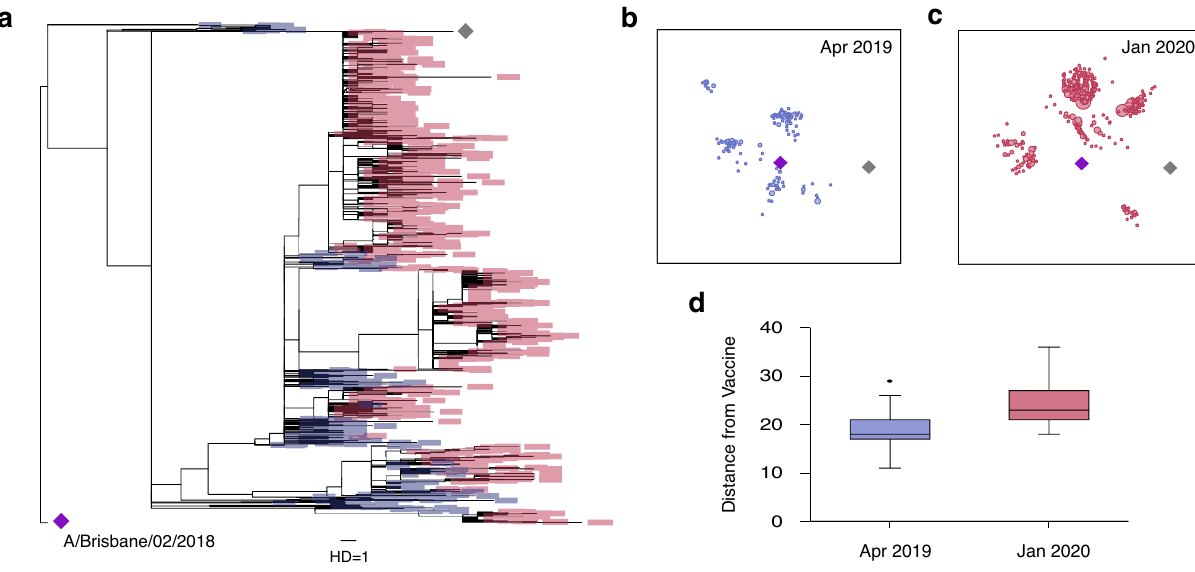
Figure 4. Influenza A (H1N1) evolution and vaccination. (a) Maximum likelihood tree of 255 H1N1 Hemagglutinin (HA) sequences sampled in April 2019 (blue boxes), 1140 H1N1 HA sequences sampled in January 2020 (red boxes), 2019–2020 H1N1 Northern hemisphere vaccine strain (A/Brisbane/02/2018, purple diamond) and 2018–2019 vaccine strain (A/Michigan/45/201, grey diamond). All HA nucleotide